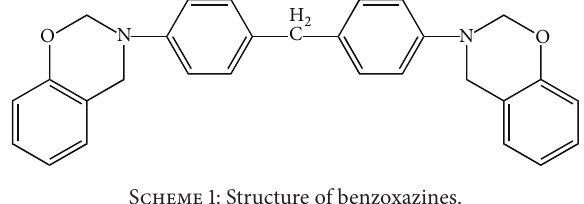
Scheme 1: Structure of benzoxazines.